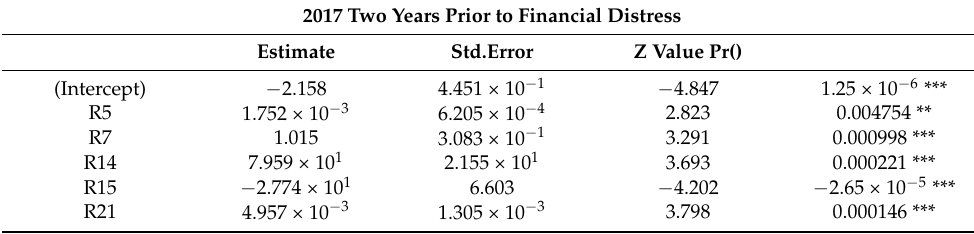
Table 4. Stepwise logistic regression results in 2017.